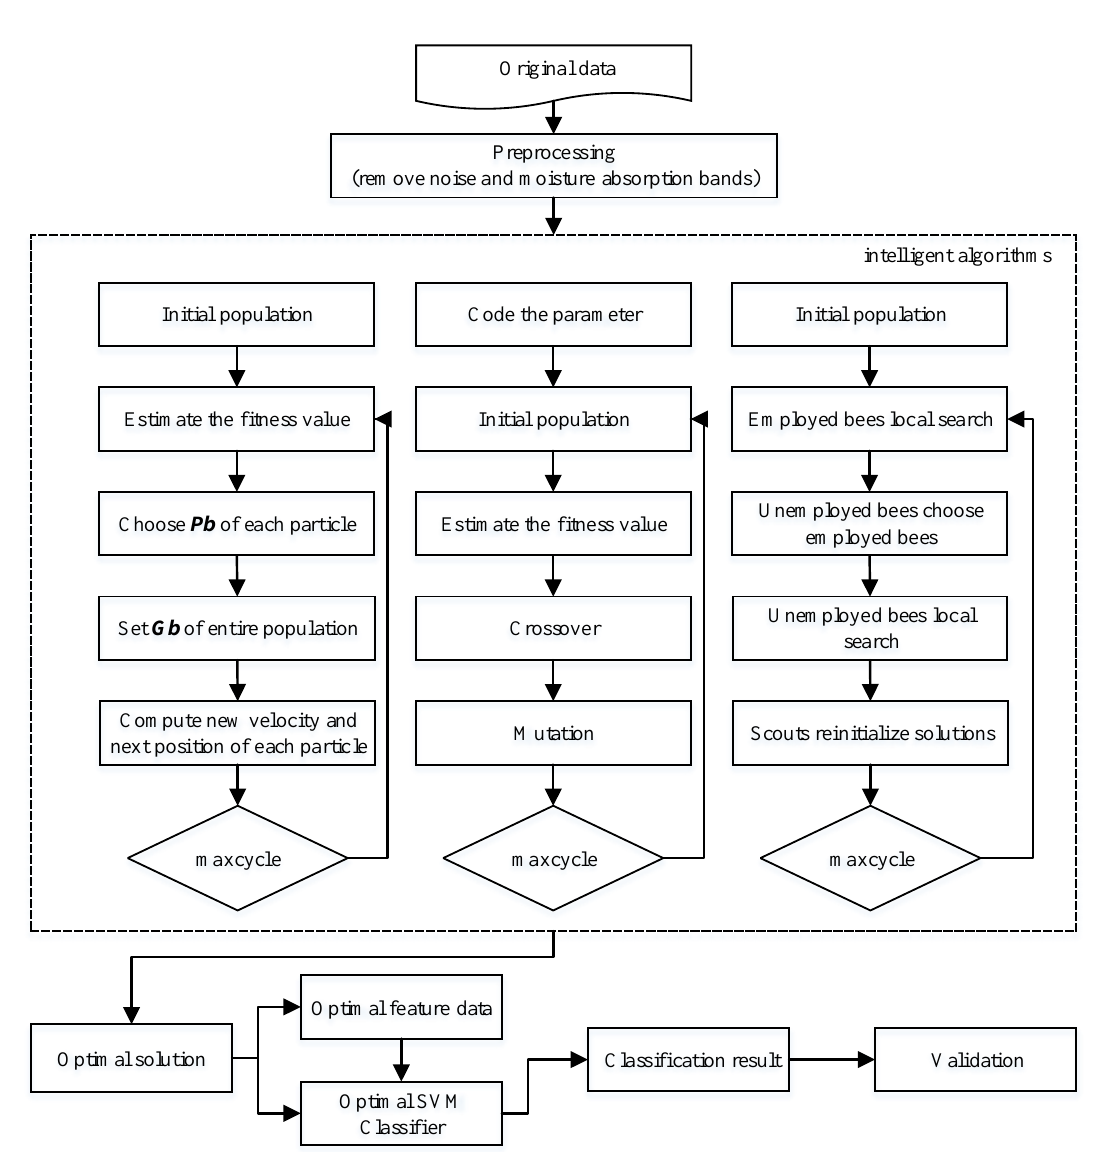
Figure 2. SVM classification process based on the three optimization algorithms.